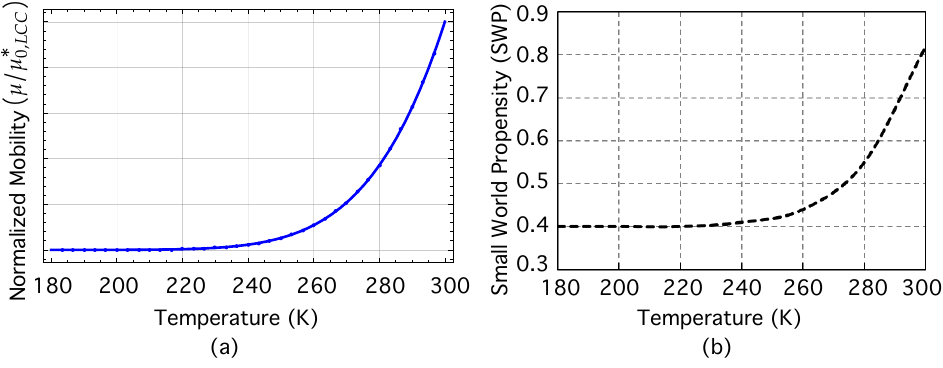
Figure 4. ( a ) Normalized mobility µ concentration (relative concentration n T (K). The number of network nodes is N = 10